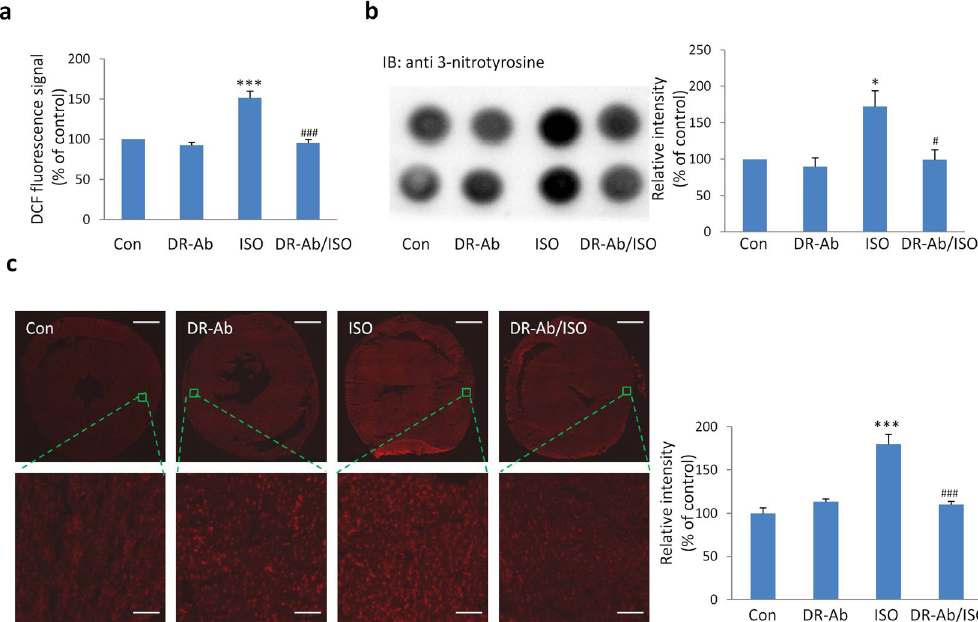
Figure 3. DR-Ab alleviates Isoproterenol (ISO)-induced oxidative stress. ( a ) DCF florescence of heart lysates in each group after incubation with H 2 DCF-DA for 45 min (n = 4); ( b ) Representative dot blots and quantification of total 3-nitrotyrosine levels (n = 4); ( c ) Representative images of DHE staining on the whole heart slice and enlarged view in each group. Fluorescent images of whole heart section were obtained via tile scanning with Leica DMi8 automated system. Right, quantitative results of the DHE staining in each group (3 hearts per group and 6 areas per heart). Scare bar, 1 mm for whole heart slice and 50 μ m for enlarged view. Mean ± SEM. * p < 0.05, *** p < 0.001 vs control; # p < 0.05, ### p < 0.001 vs